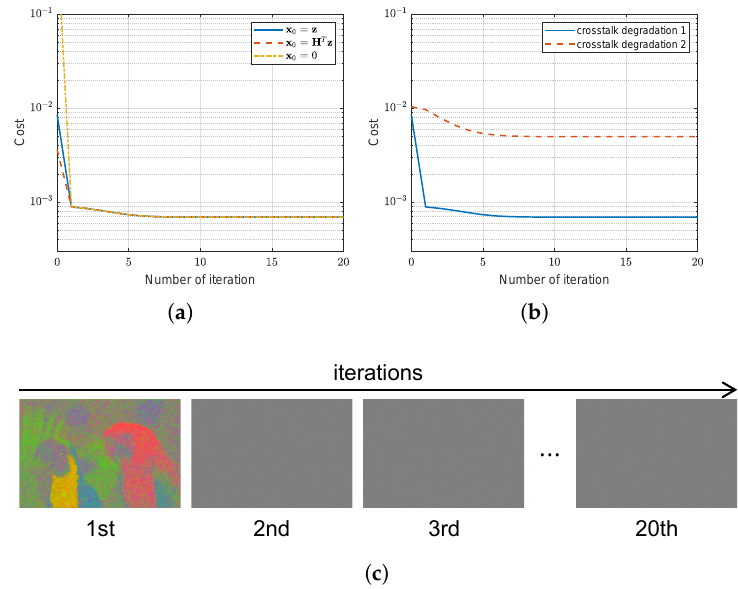
Figure 12. Convergence for test image Parrot : ( a ) Value of cost function versus iteration number of various initial conditions for crosstalk degradation 1 (crosstalk kernel with σ g = 0.45 and noise with σ n = 0.01); ( b ) value of cost function versus iteration number of various degradation conditions; and ( c ) visualization of residual image versus iteration number at crosstalk degradation 2 (crosstalk kernel with σ g = 0.6 and noise with σ n =